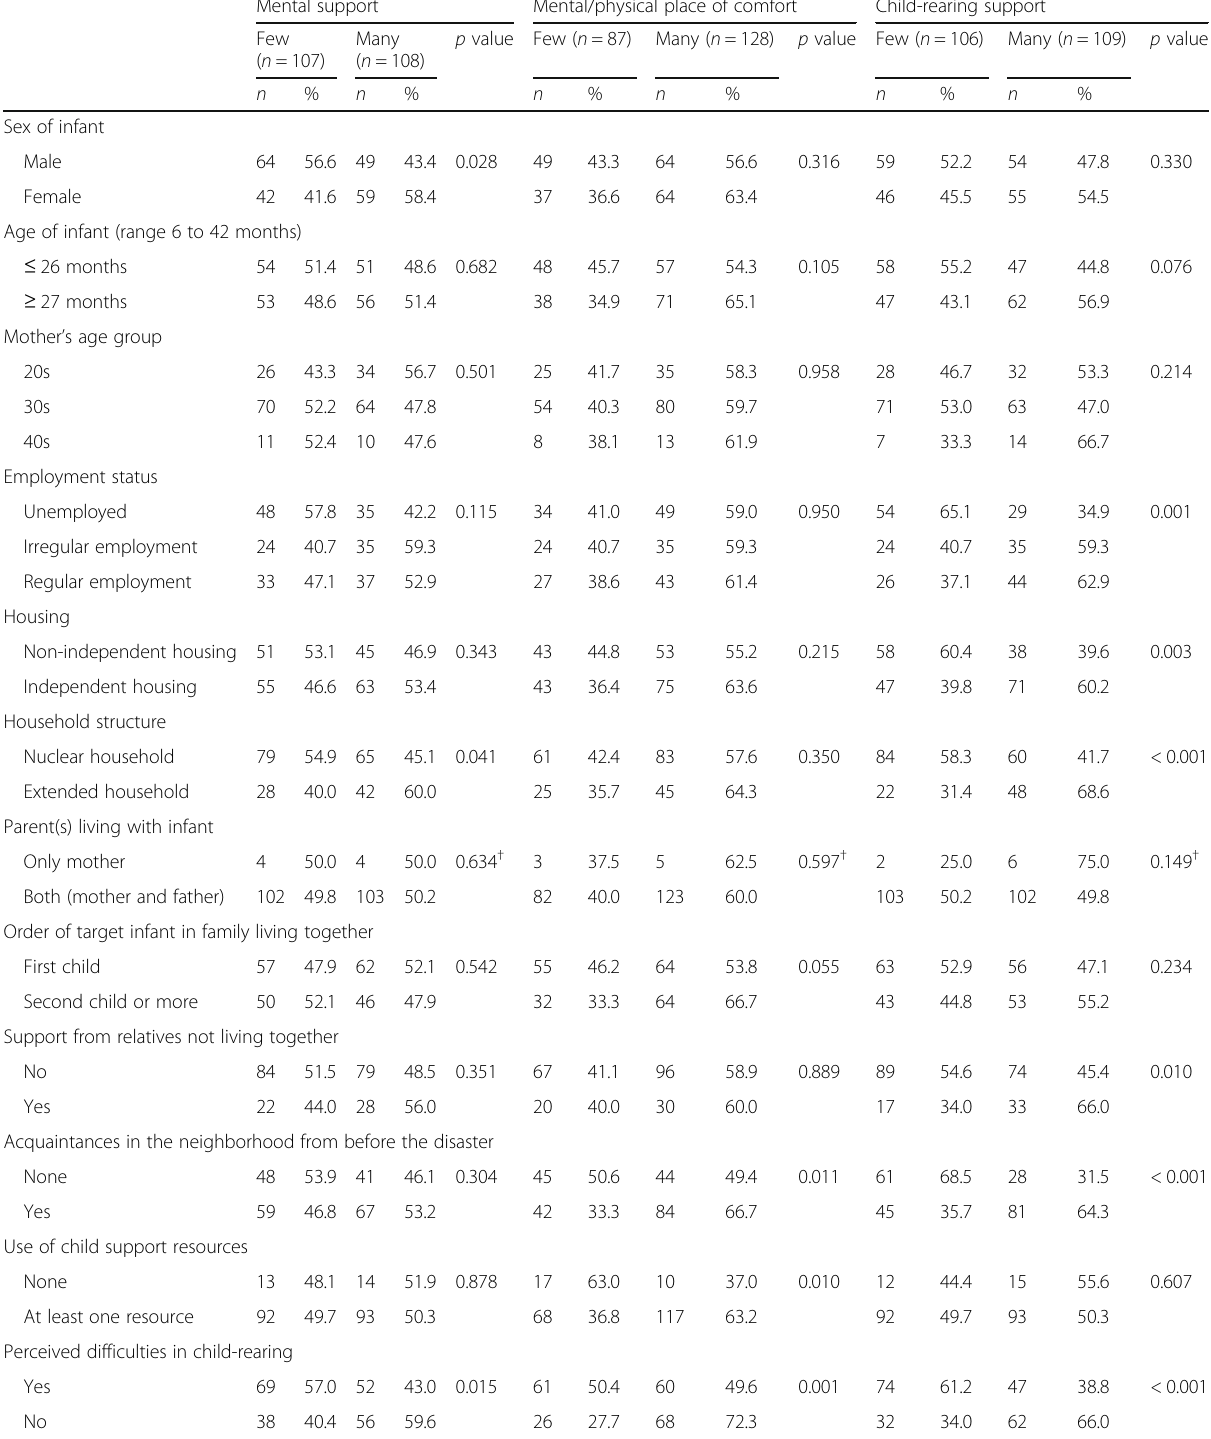
Table 2 Factors related to social support among mothers living in a house different from their house before the disaster ( n = 215) Mental support Mental/physical place of comfort Child-rearing